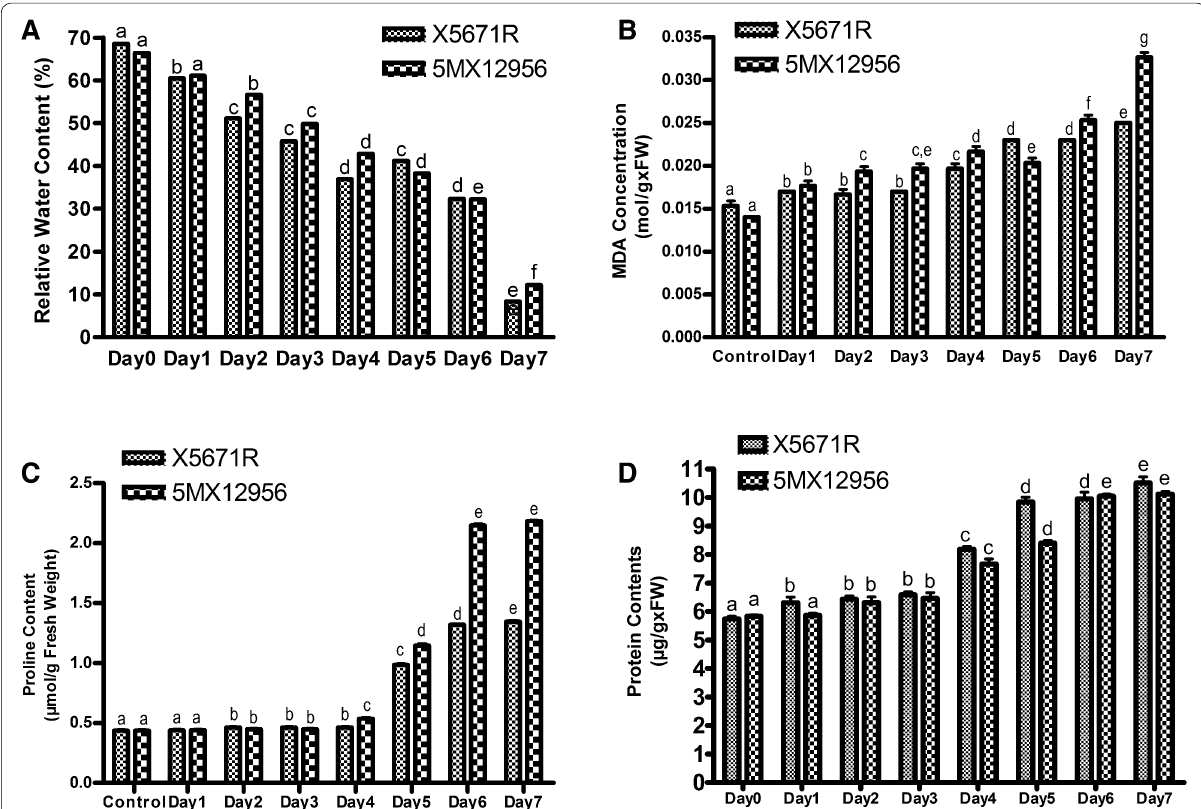
Fig. 1 Effects of 7 day drought stress on relative water content ( A ), lipid peroxidation rate ( B ), proline content ( C ) and total protein concentration ( D ) of X5671R and 5MX12956 tomato seedlings. Data represent the average of three independent experiments with three replicates. Vertical bars indicate SEM and the differentially given letters represent significance at the 0.05 ±